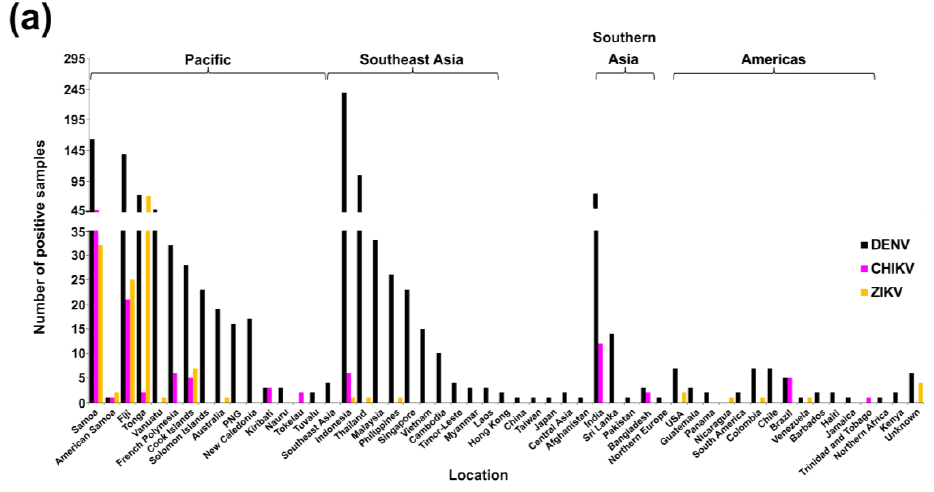
Figure 8. Cont. Figure 8. Cont.